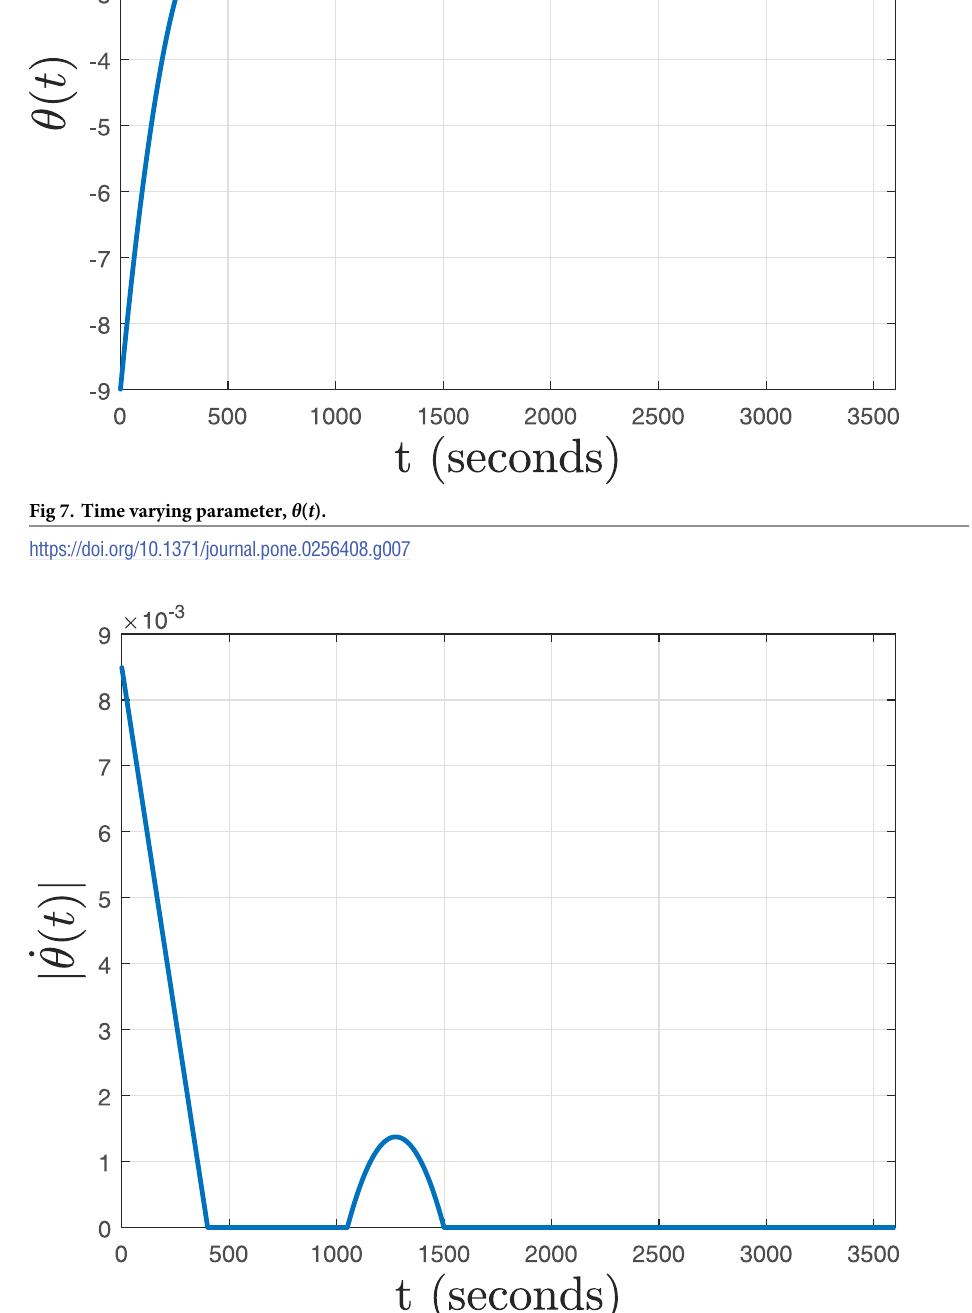
Fig 8. Rate of parameter variation, j _ y ð t Þj .